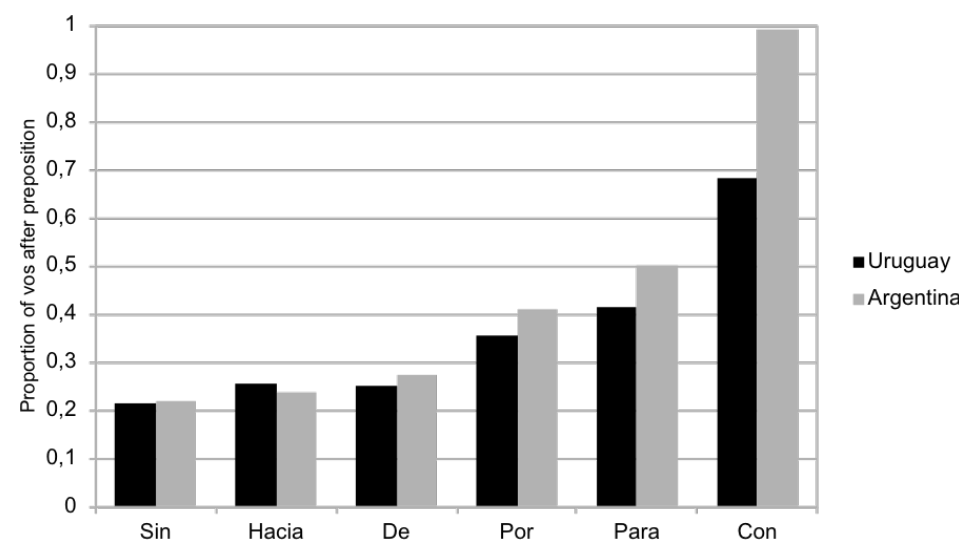
Figure 1. Proportion of vos following six